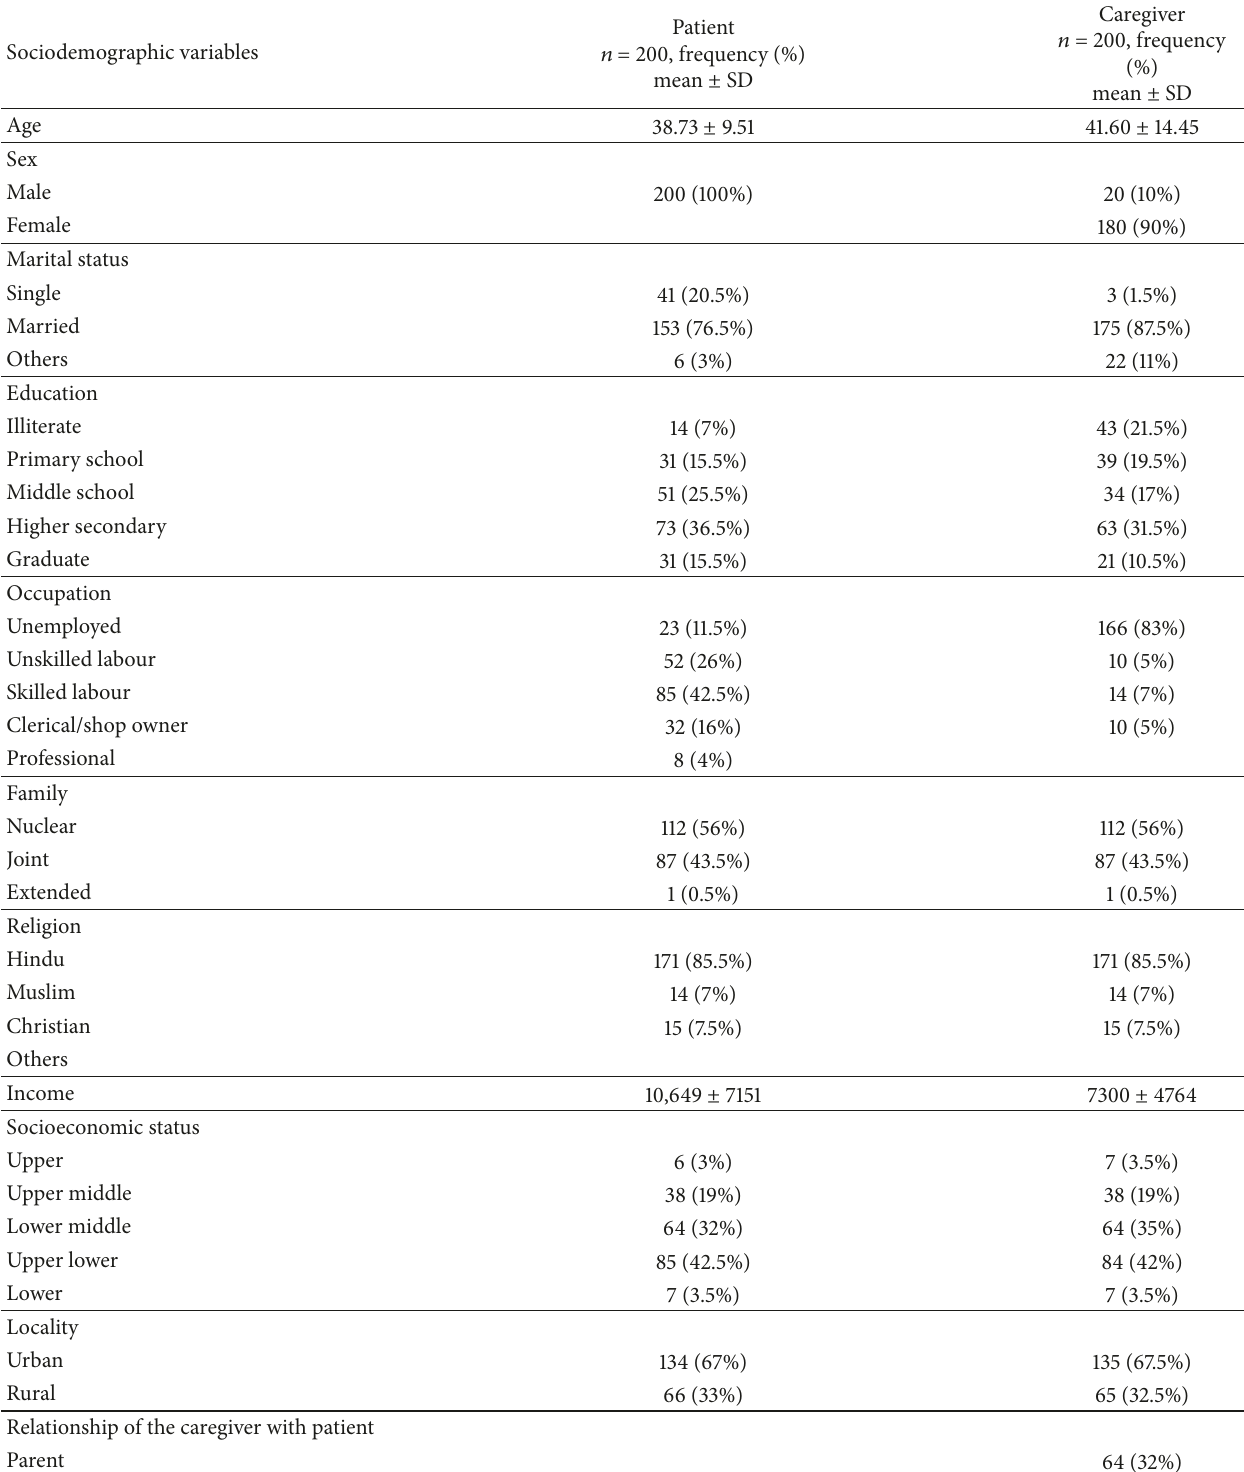
Table 1: Sociodemographic profile of the patients and